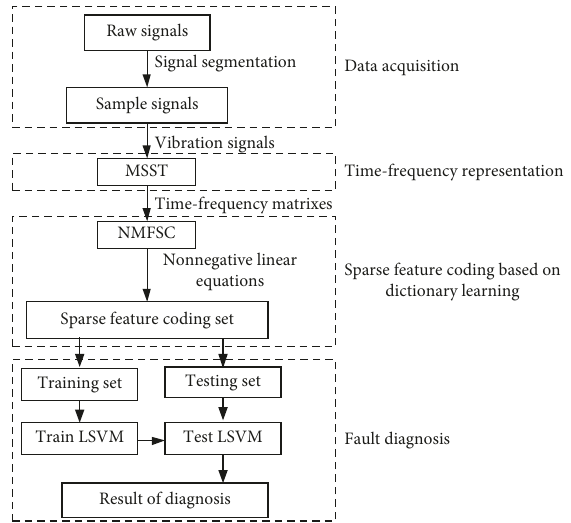
Figure 1: Flowchart of the presented fine-grained fault diagnosis